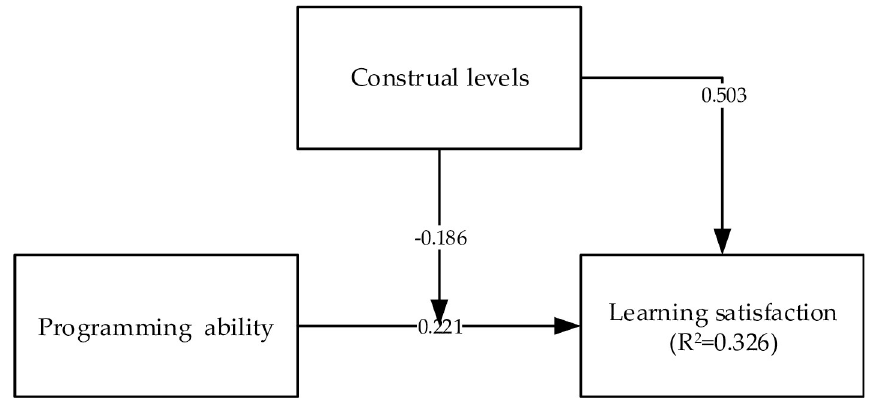
Fig 5. Research model and PLS analysis results.